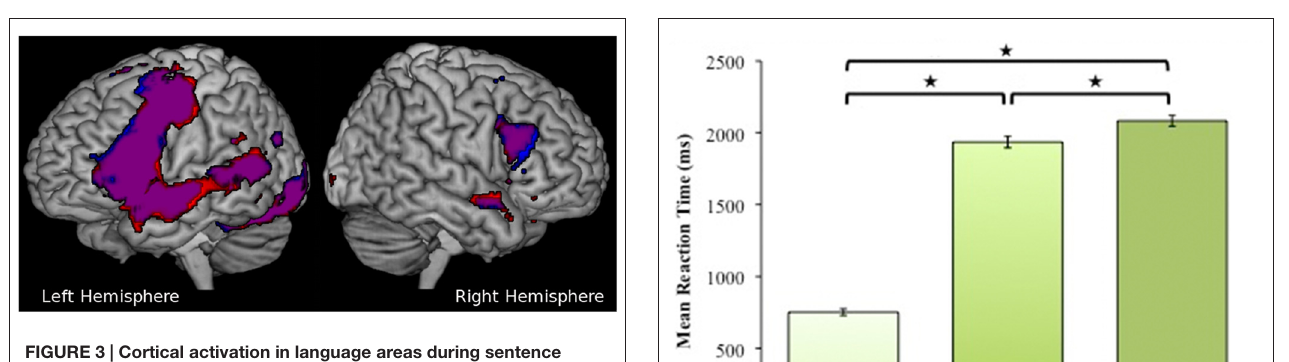
FIGURE 3 | Cortical activation in language areas during sentence reading. The results of the group activation in both hemispheres during congruent sentence reading are shown in red, activation during incongruent sentence reading is shown in blue. The violet shaded areas show overlap in activation between the two conditions. For visualization purposes only, the activation in this figure was thresholded at p = 0.001, significant results are presented in Table 1 .